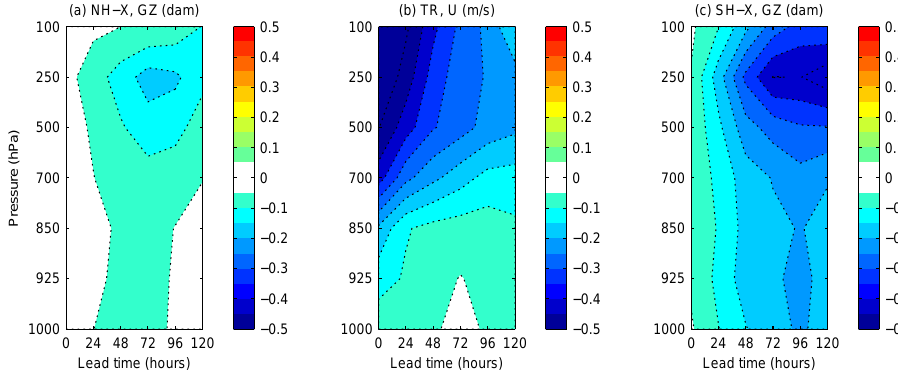
Fig. 6. Same as the previous figure, except for the July/August 2011 period.